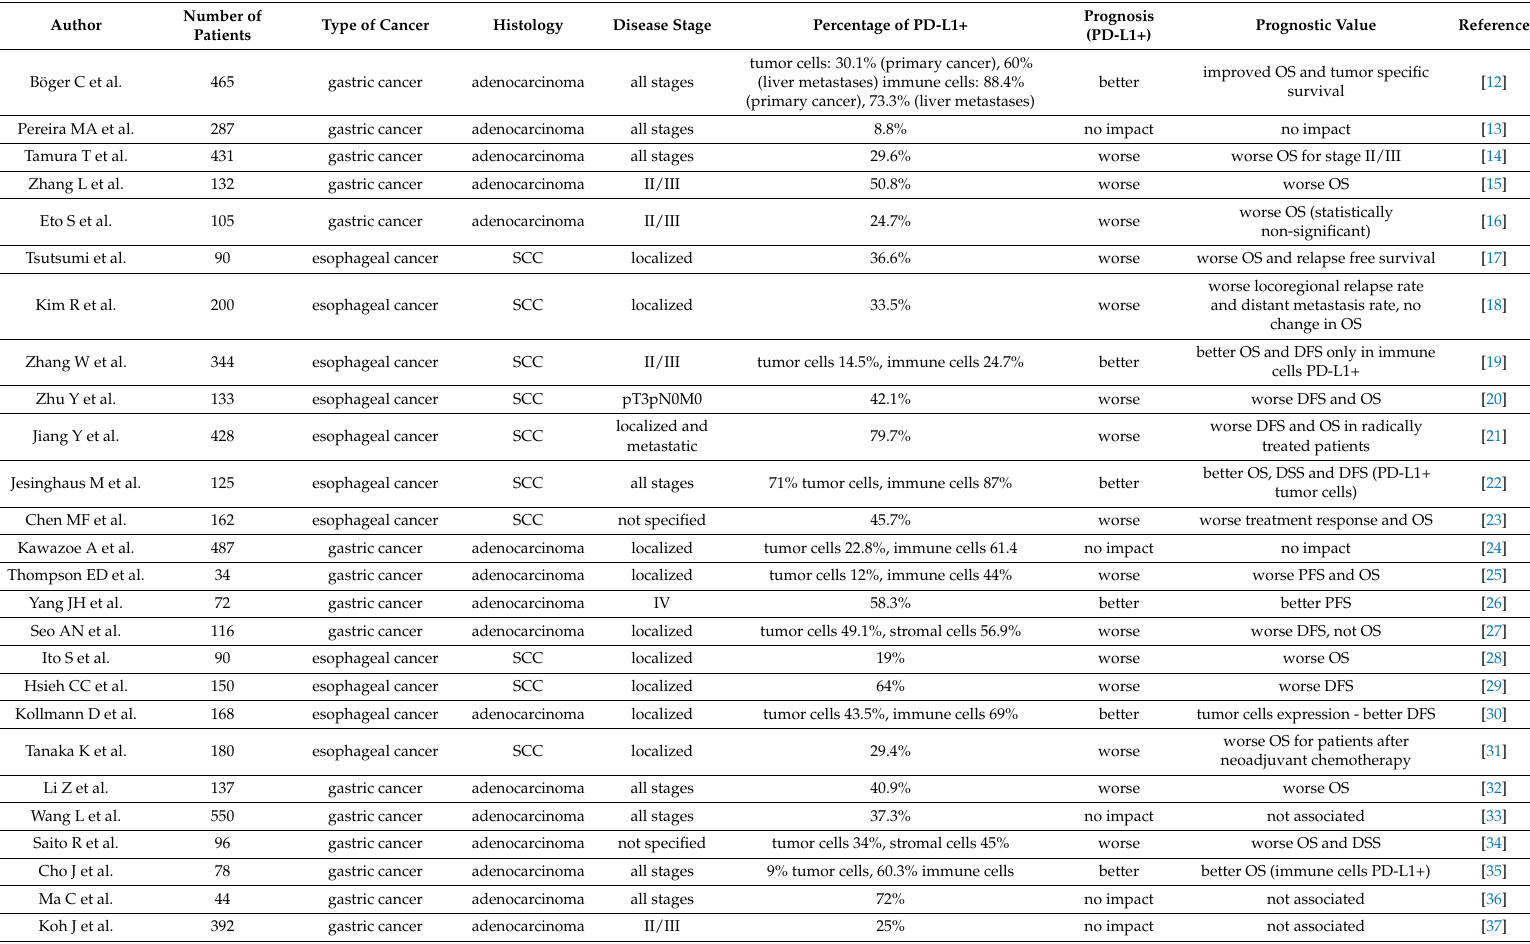
Table 1. Prognostic significance of PD-L1 expression in gastric and esophageal